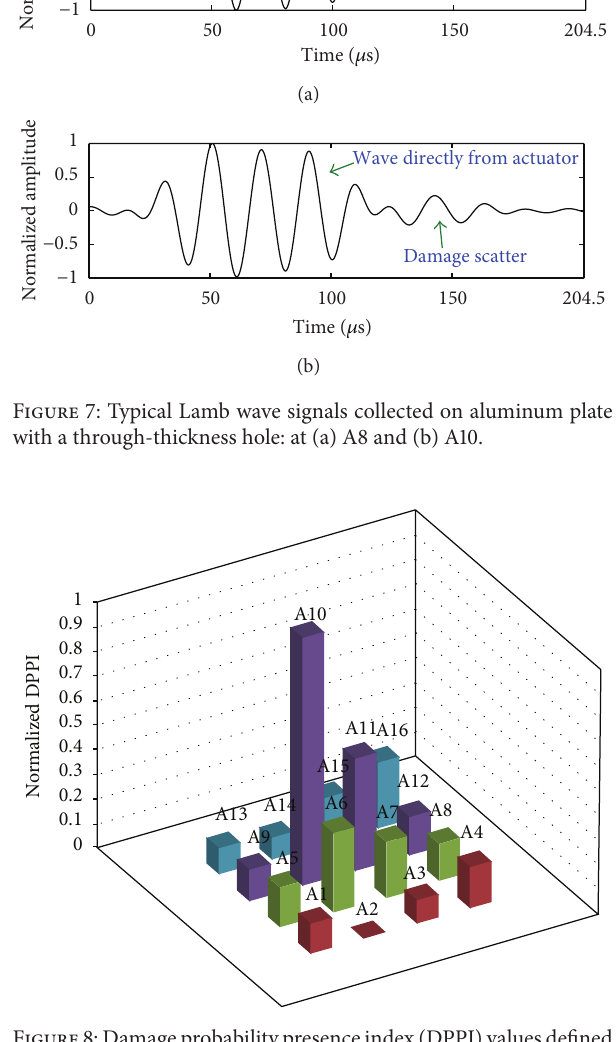
Figure 8: Damage probability presence index (DPPI) values defined at different areas of aluminum plate with through-thickness